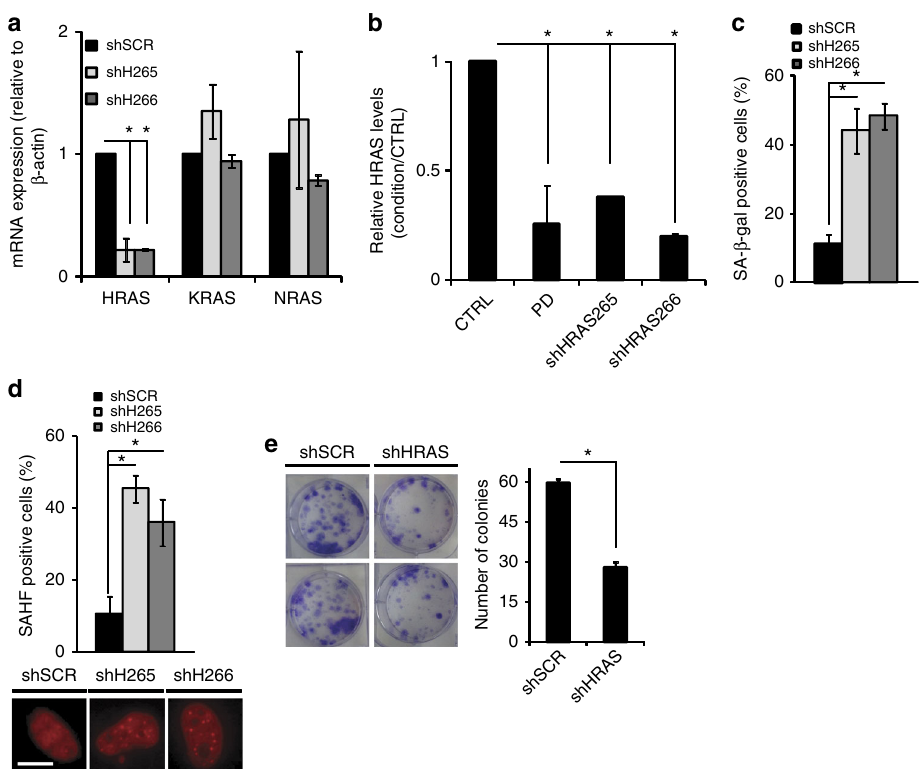
Fig. 8 Reducing HRAS expression can drive quiescent cells into senescence. a HRAS was stably knocked down with two independent hairpins each in cycling LS8817 cells and transcript levels were measured by qPCR. Expression levels of the indicated genes were individually normalized to 1 in the shSCR cells. b – e LS8817 cells were serum starved for 3 days and subsequently infected with the indicated shRNA encoding lentiviruses. After an additional 5 days of selection, the accumulation of HRAS mRNA ( b ), SA- β -gal ( c ), and SAHF ( d ) were measured. Representative SAHF images are shown ( e ). Long-term clonogenicity was measured by crystal violet staining of colonies 3 weeks after the cells were replated in complete medium. Representative images are shown ( left ) and colony numbers are quanti fi ed ( right ). all data are represented as mean ± SEM from three independent experiments. Asterisk indicates p < 0.05 using a two-sided Students t- test. All images were taken at the same magni fi cation. The scale bar is 20